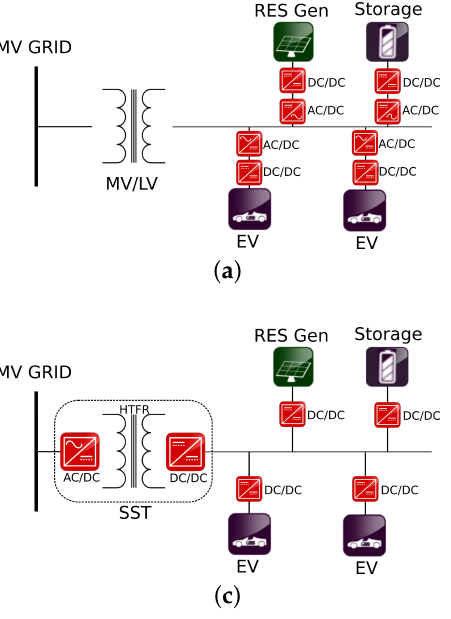
Figure 4. Charging station connection architecture: ( a ) common AC bus, ( b ) common DC bus, ( c ) solid state